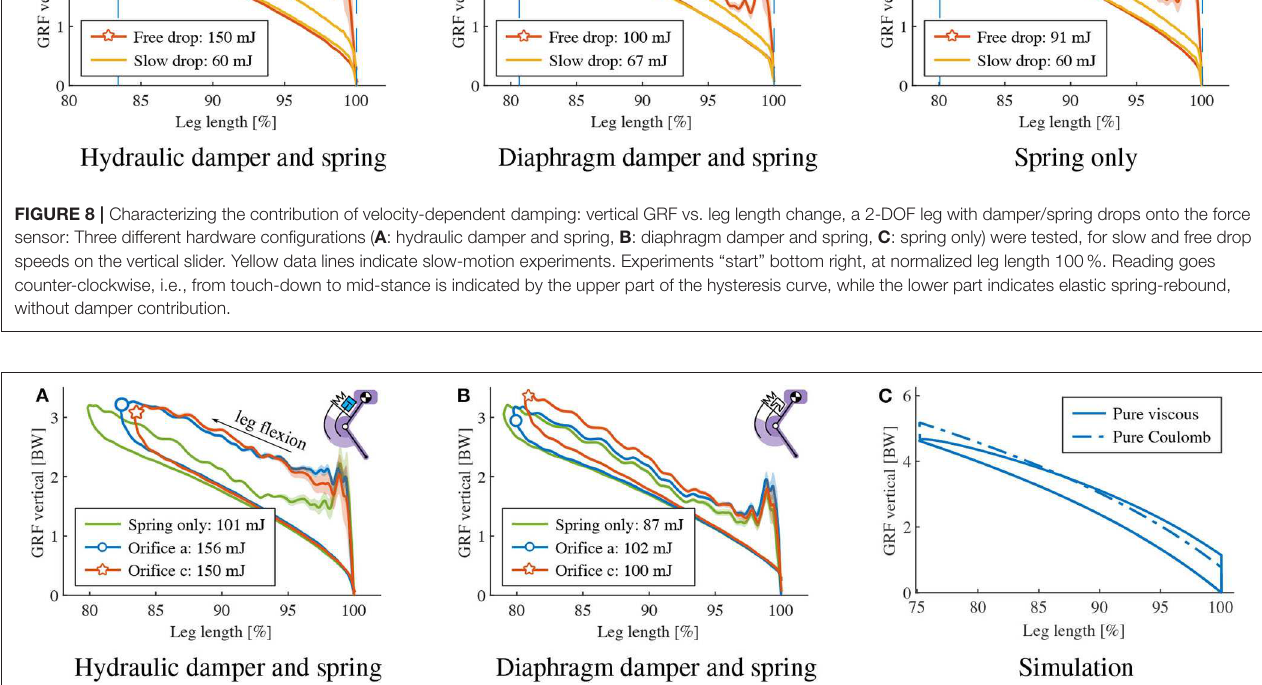
FIGURE 9 | Adjustability and tunability of damping: vertical GRF vs. leg length change, a 2-segment leg with damper and spring drops onto the force sensor. Two different hardware configurations were tested, for different orifice settings. Panels (A,B) show the result from hydraulic damper and diaphragm damper, respectively, where the green data lines indicate the leg drop without damper for comparison. (C) : Simulated approximation of hydraulic damper orifice a by a pure viscous and a = 156mJ, respectively—pure viscous damper: d c = 0N and d v = Coulomb damper. Damping coefficients are chosen to allows same dissipated energy, i.e., E D 0 51Ns/m; pure Coulomb damper: d c = 13.2N and d v = 0Ns/m. None of the two curves can fully capture the work-loop of hydraulic damper.